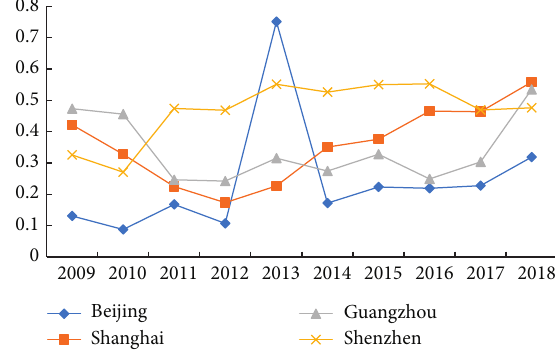
Figure 4: 2009–2018 Beijing, Shanghai, Shenzhen, and Guangzhou urban green output